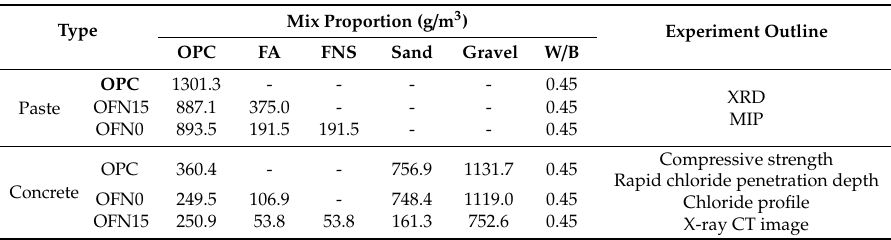
Table 2. Mix proportion and experimental